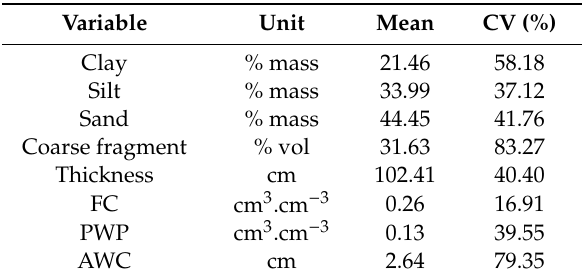
Table 3. Basic statistics of soil properties for soil horizons.